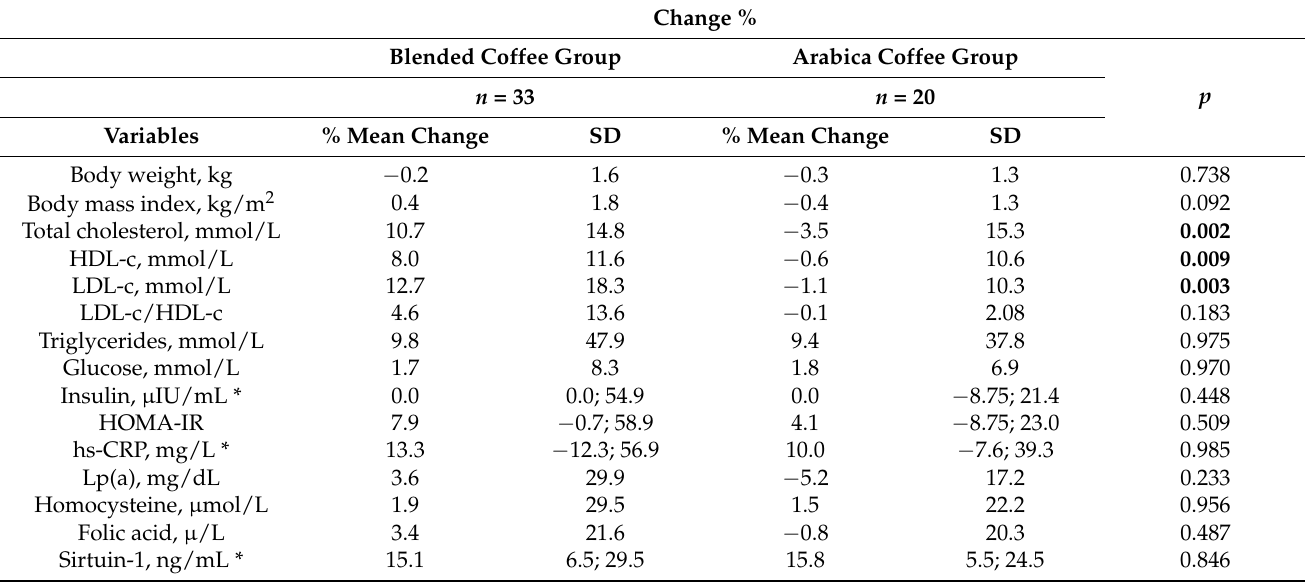
Table 2. Comparison of percentage changes between groups.